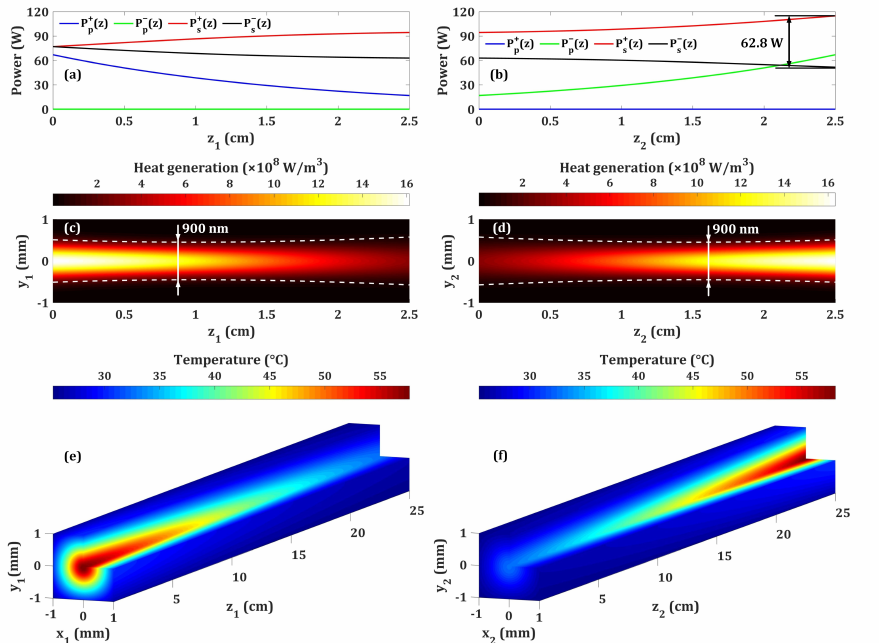
Figure 3. Power distributions along the z -axis in ( a ) Xtal 1; ( b ) Xtal 2, heat generation distributions of ( c ) Xtal 1 at face x 1 = 0; ( d ) Xtal 2 at face x 2 = 0 and temperature distributions within ( e ) Xtal; and ( f ) Xtal 2 for the continuous-wave